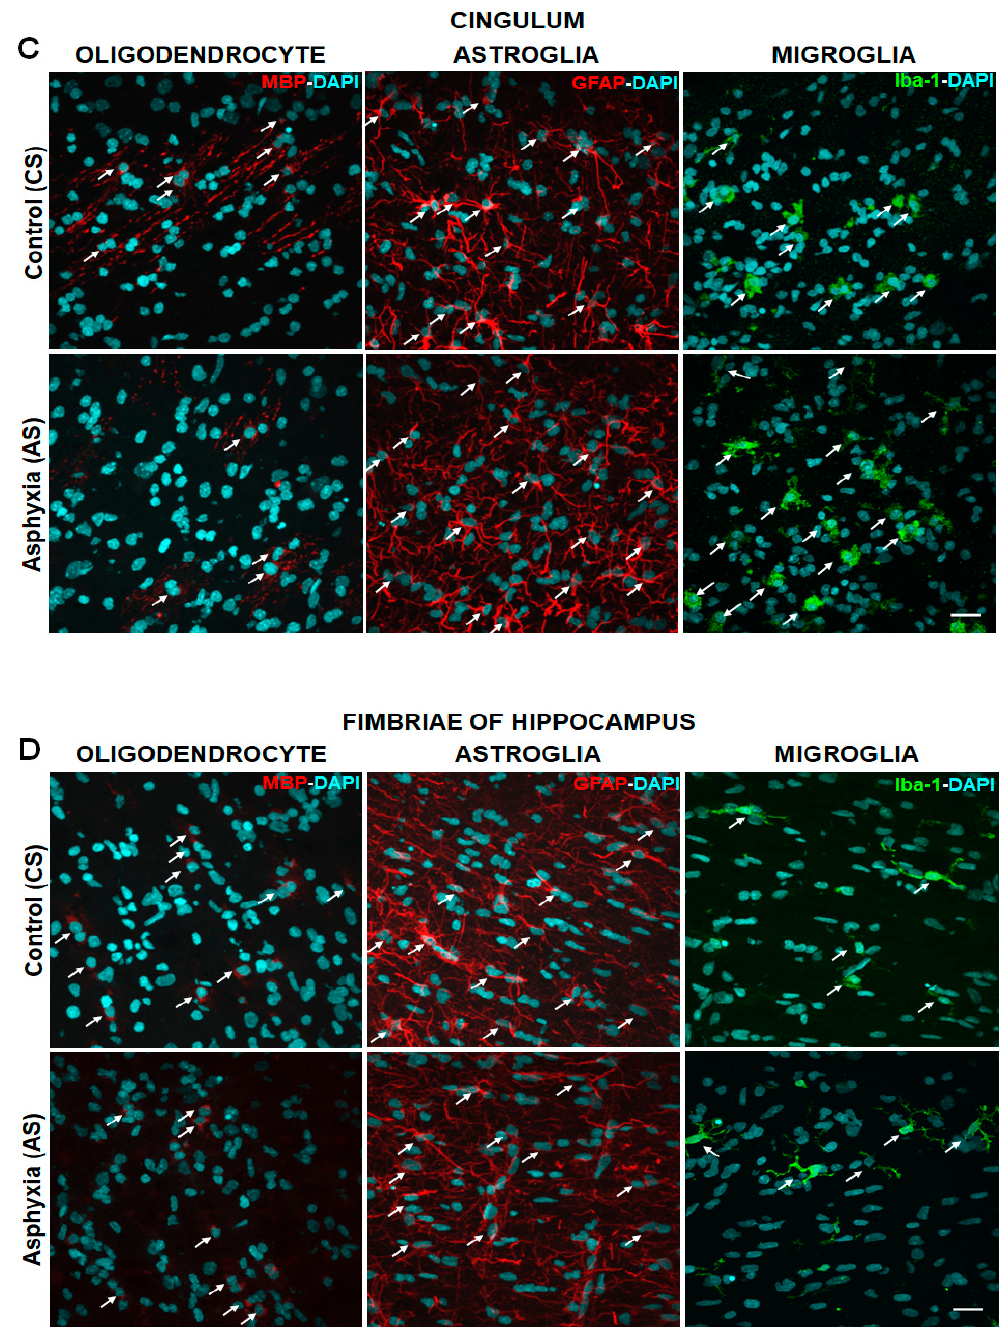
Figure 2. Effect of perinatal asphyxia (PA) on glial cells at P7, measured in external capsule ( A ); corpus callosum ( B ); cingulum ( C ); and fimbriae of hippocampus ( D ) of rat neonates. Representative microphotographs obtained by confocal microscopy showing myelin basic protein (MBP; red), glial fibrillary acidic protein (GFAP; red), ionized calcium binding adaptor molecule 1 (Iba-1; green) and DAPI (blue; nuclei)-positive cells in external capsule (2A); corpus callosum (2B); cingulum (2C); and fimbriae of hippocampus (2D), from control (CS) and asphyxia exposed (AS) rat neonates. White arrows show mature oligodendrocyte (OL), astrocyte, and microglia phenotype. Scale bar: 20 µ m. At P7, the number of MBP-DAPI+ cells/mm 3 decreased after PA in external capsule, corpus callosum, and cingulum, but not in fimbriae of the hippocampus.